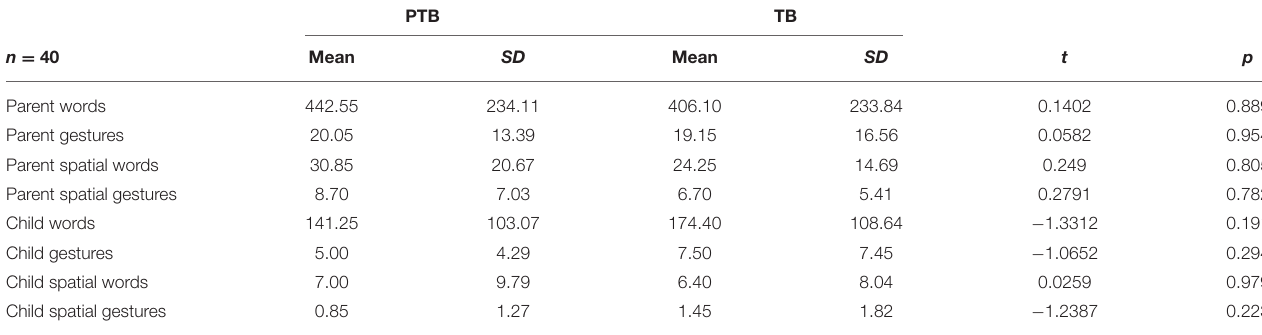
TABLE 3 | Descriptive statistics for parent and child overall and spatial words and gestures by prematurity group (PTB, TB). PTB TB n = 40